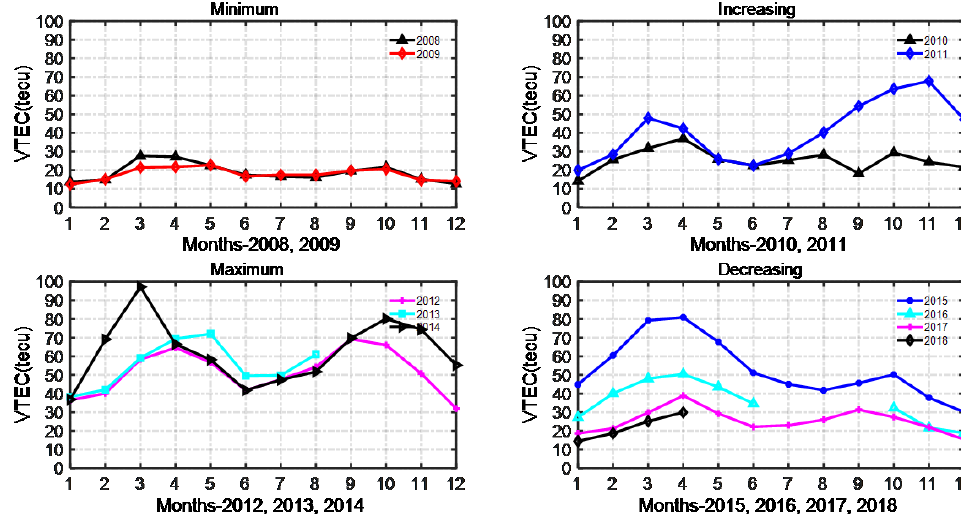
Figure 8. VTEC variability in GRHI station during minimum, increasing, maximum and decreasing phases of solar cycle